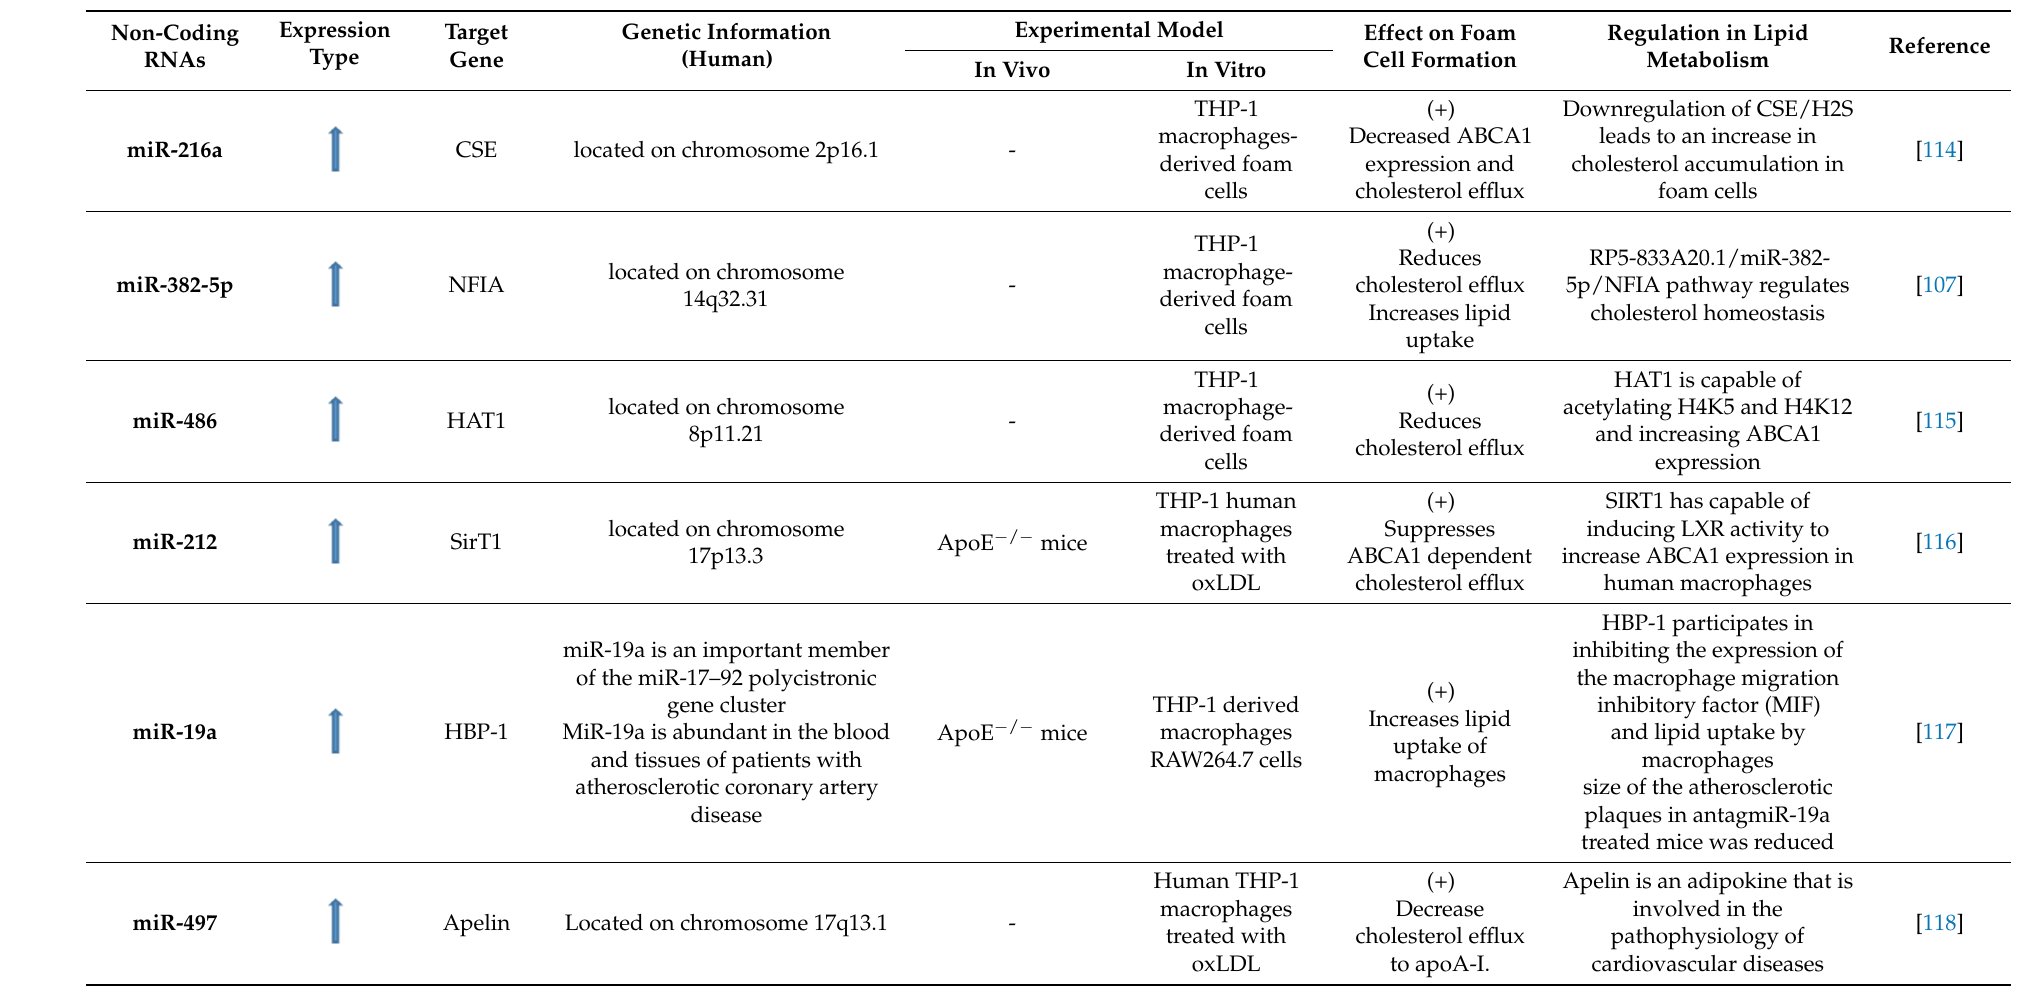
Table 1. Non-coding RNAs that stimulate foam cell formation/function.